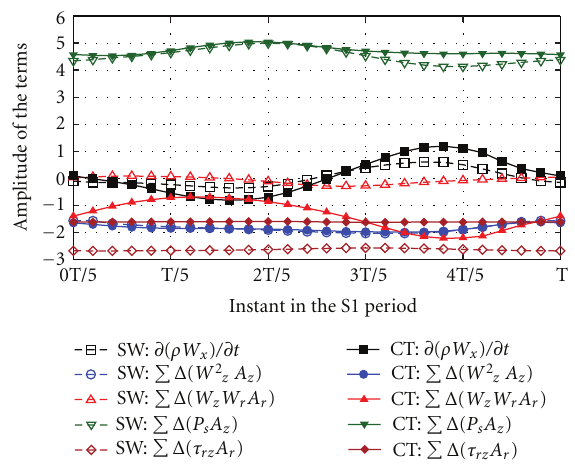
Figure 15: CBUAA with and without CT: temporal evolution of the main terms of the unsteady axial momentum